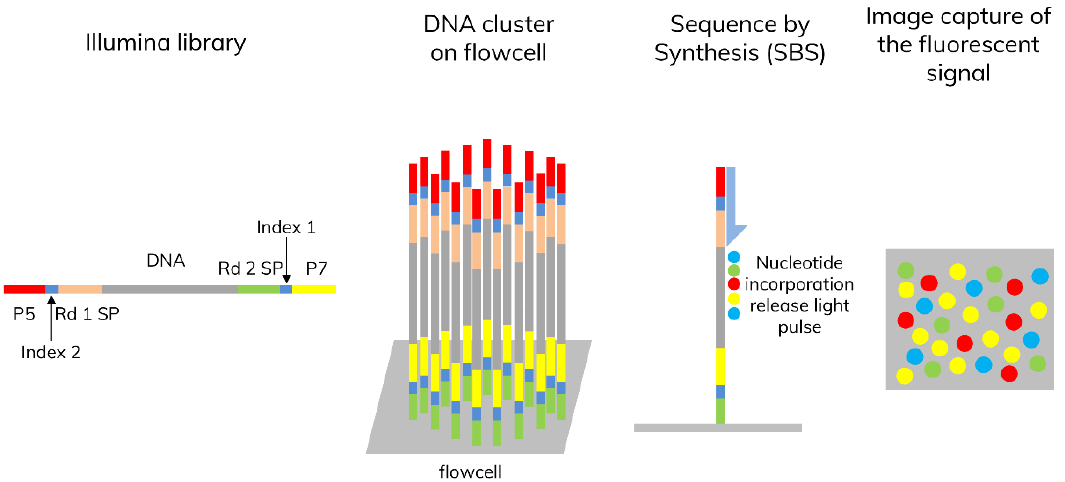
Figure 2. Illumina sequencing by synthesis (SBS). DNA templates are immobilized on a flowcell. When nucleotides are incorporated onto the DNA strands, they release light pulses that are captured by the sequencer and output the bases read from each cluster, along with the quality metrics for each base.